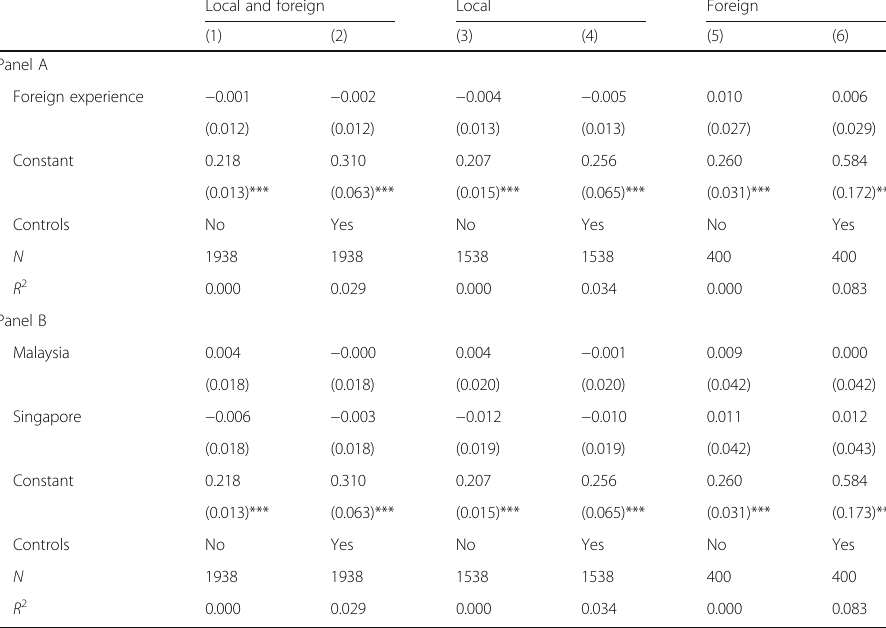
Table 9 Dependent variable: if a resume receives a callback for an interview (all occupations) Local and